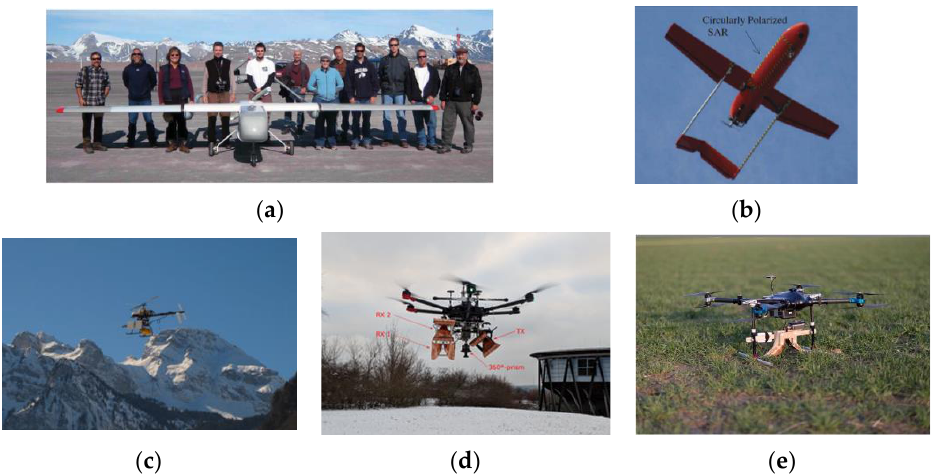
Figure 16. Examples of types of UAS: Fixed-wing ( a ) (after [60]) and ( b ) (after [61]); and multi-copter ( c ) (after [14]), ( d ) (after [45]), and ( e ) (after [62]).